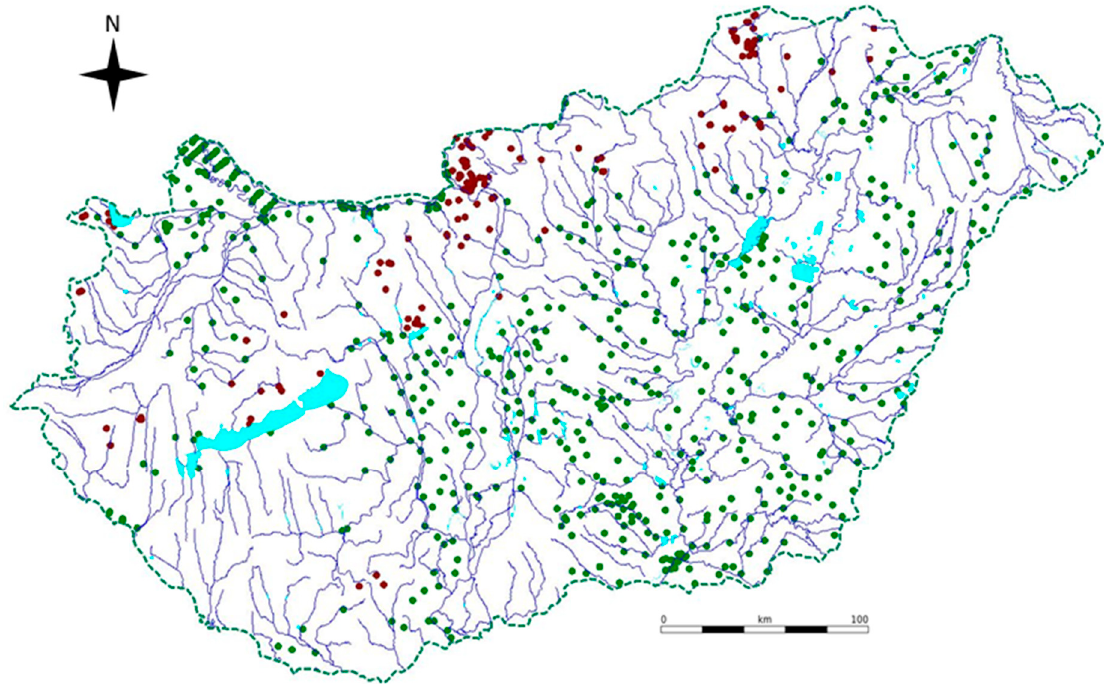
Figure 11. Applied boundary conditions and calibration data points. Blue lines indicate rivers, green dots indicate monitoring bores and red dots indicate springs.